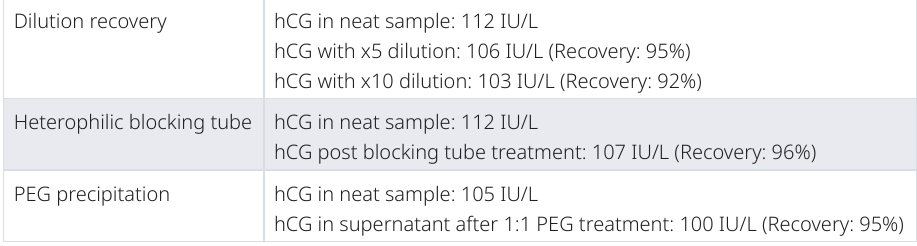
Table 2. Results of interference studies performed on patient’s serum specimen. Dilution recovery hCG in neat sample: 112